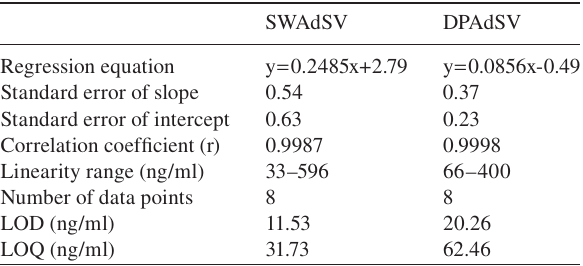
Table 1 Data of the calibration curves for the proposed methods (n = 7).